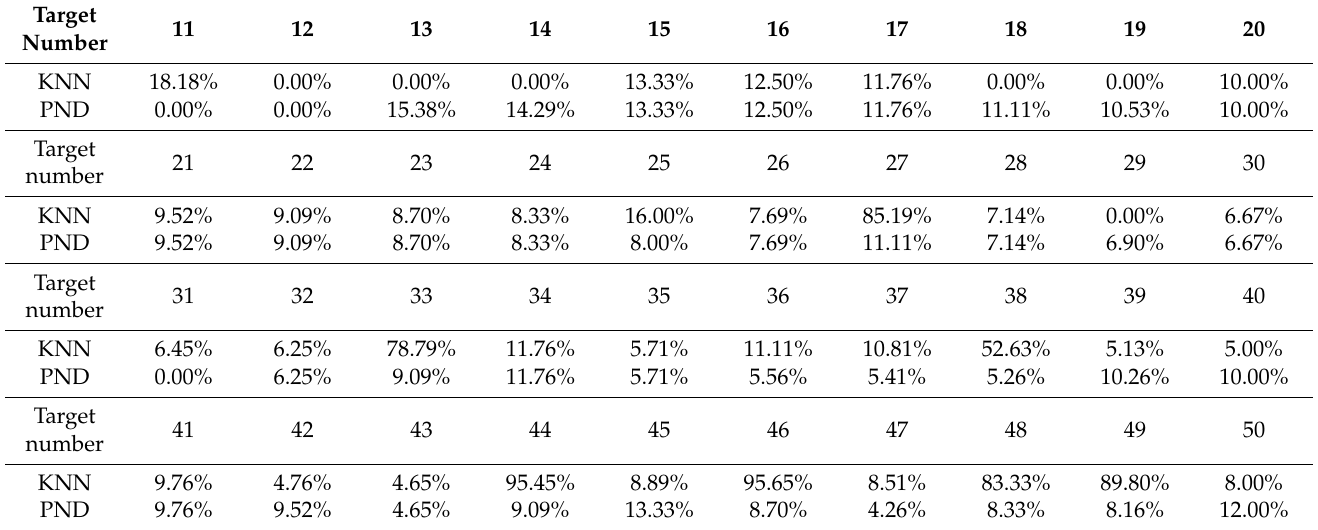
Table 8. Maximum false correlation rate under different target numbers in Scenario 2.